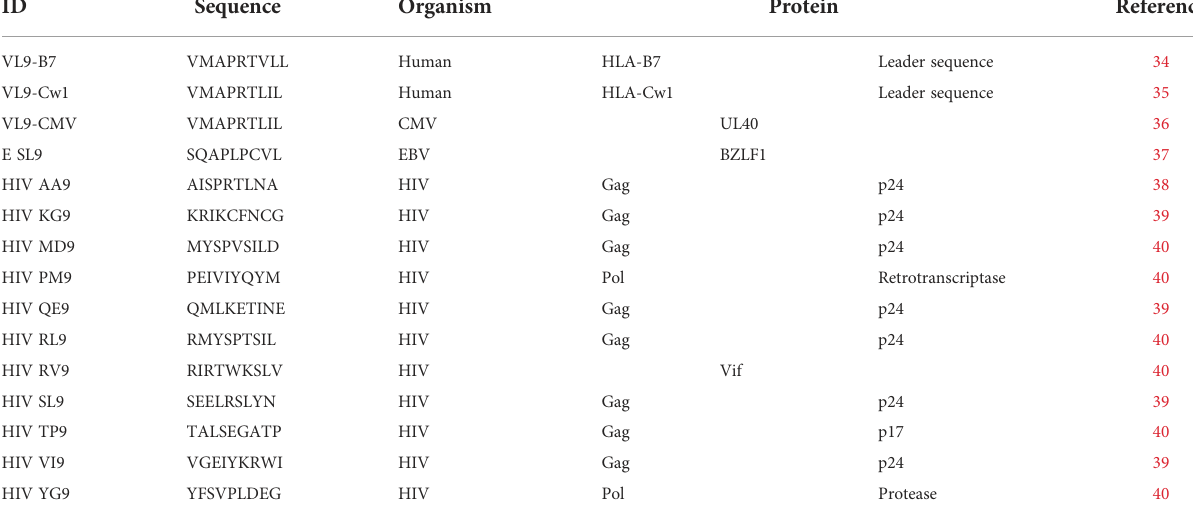
TABLE 1 HLA-E binding epitopes tested in this